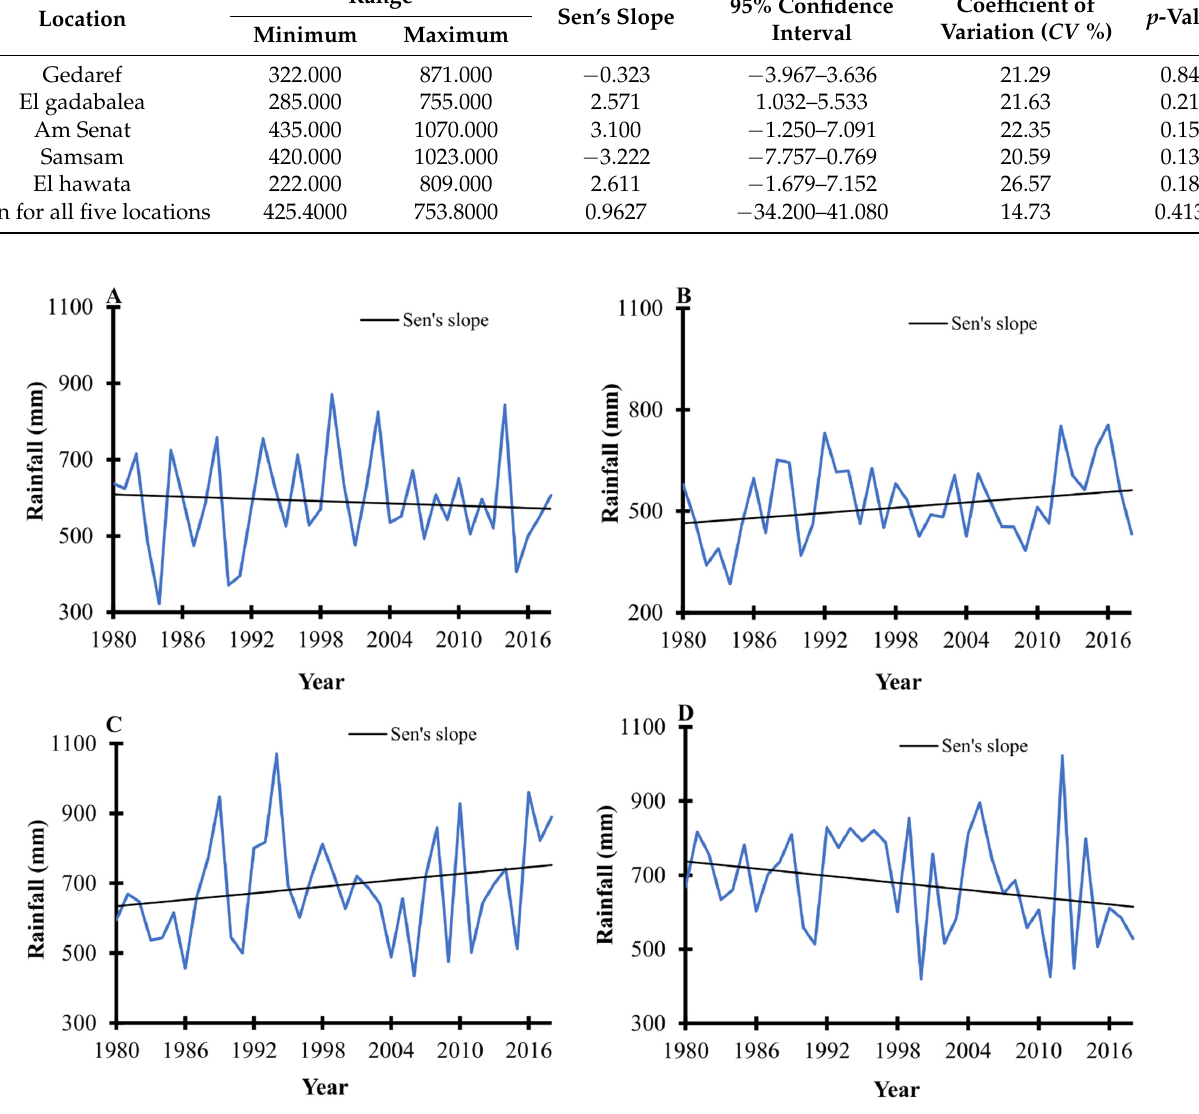
Figure 4. Annual rainfall trends in five locations in Gedaref state, Sudan between 1980 and 2018. ( A ): Gedaref, ( B ): El gadabalea, ( C ): Am Senat, ( D ): Samsam, ( E ): El hawata, and ( F ): Average rainfall for all five locations. 3.3. Assessment of Annual Crop Yield Trends in Gedaref State The trend analysis showed a decrease in the annual yield of the five studied crops between 1970 and 2018, with the exception of sunflower and sesame, which had a yield increment (Table 3; Figure 5). However, there was a significant yield change for sorghum ( p < 0.01) and sunflower ( p < 0.001) only (Table 3; Figure 5). In specific, sorghum and cotton